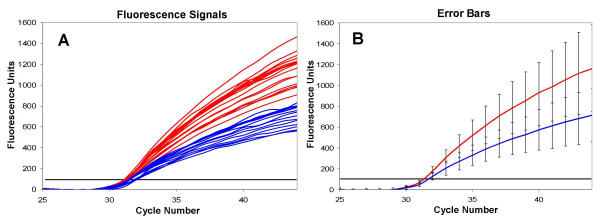
Fluorescent signal scatter in LATE-PCR assays. Panel A: Kinetic plots of accumulated amplification products detected by the molecular beacon probe in replicate samples. Replicate sets of homozygous normal (red lines) and heterozygous (blue lines) samples for the TSD Δ1278 allele (n = 18 each) were amplified using LATE-PCR and monitored in the course of the reaction using a molecular beacon probe against the normal allele. Each reaction contained 1000 genomes equivalent of genomic DNA. Panel B: Statistical analysis of data in Panel A. Solid lines correspond to the average fluorescence values of each replicate set (red: homozygous normal samples; blue: heterozygous samples), error bars correspond to three-standard deviations of the mean which encompasses 99.7.% of all possible samples in each replicate set distribution. LATE-PCR does reduce the overlap between the error bars of each replicate set compared to Figure 1 but still does not permit unambiguous identification of each genotype.